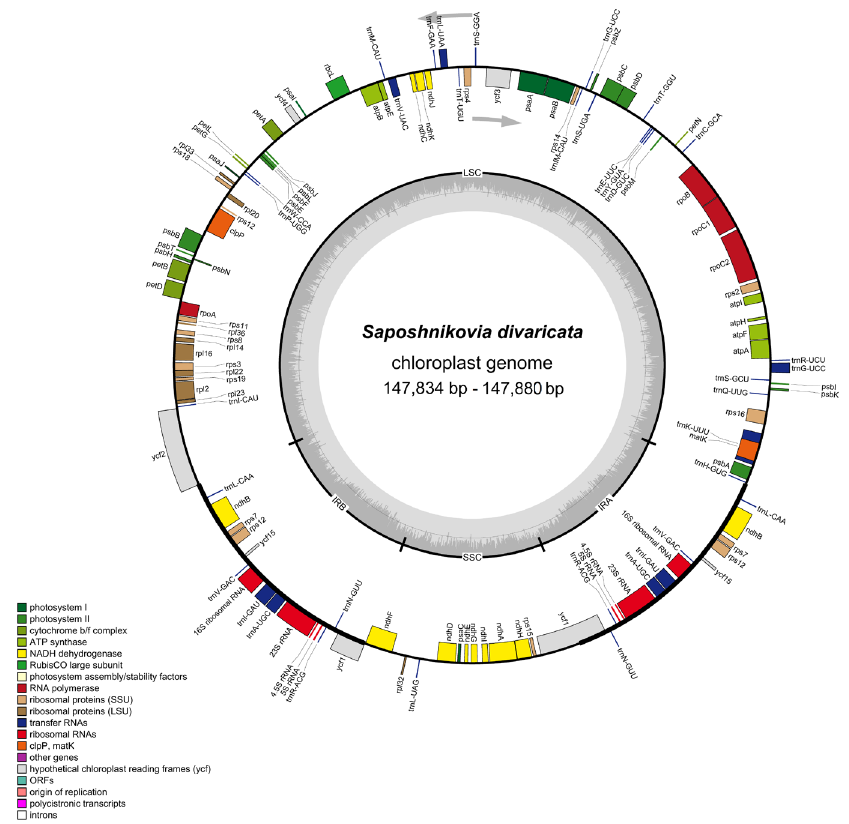
Figure 1. Chloroplast genome map showing all reported genes of Saposhnikovia divaricata . Genes drawn inside the circle are transcribed clockwise, and those outside are counterclockwise. Genes belonging to different functional groups are color-coded. The darker gray in the inner circle corre- sponds to GC content. Small single-copy (SSC) region, large single-copy (LSC) region, and inverted repeats (IRa and IRb) are displayed.